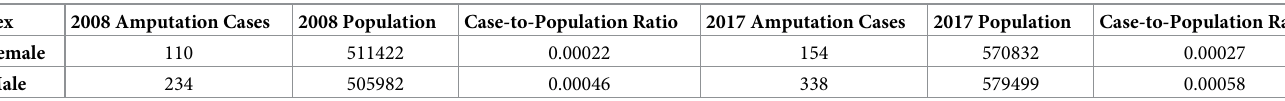
Table 1. Overall amputation case—to-population